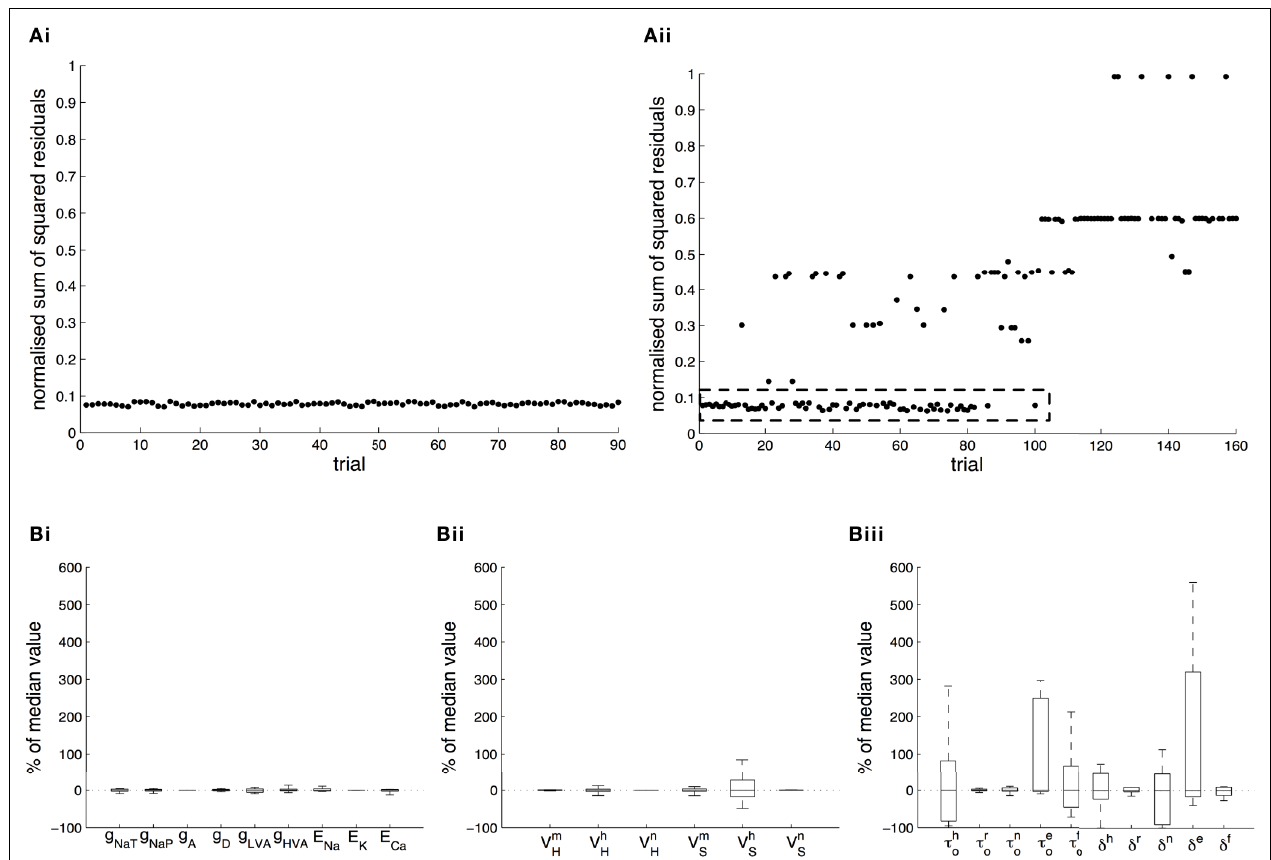
FIGURE 3 | Tolerance of optimal fi tting to variation in parameter values. simulations. (B) Examination of the estimated maximal conductance and (A) Optimization against current-clamp data was repeated from a large number reversal potential values corresponding to the optimal points illustrated in Ai of randomly selected initial values for the maximal conductances and reversal revealed that these values were tightly constrained around the median, not potentials in the model, while the rest of the parameters were kept fi xed to their exceeding 15% of this value (Bi) . Similarly, the optimal values for parameters V m previously estimated values. A total of 90 different initial values for each free parameter were tested, all of which converged to the same equally good fi t to the data at the end of the optimization (Ai) . Similarly, the optimization based on current-clamp data was repeated for parameters V x and V x ( x = m,h,n) and τ ox H S and δ x ( x = h,r,n,e,f), while the rest of the parameters in the model, including maximal conductances and reversal potentials, were kept fi xed to their value (Bii) . On the other hand, the optimal values for most of the examined x and δ x ( x = h,r,n,e,f) were rather broadly distributed around the previously estimated values. We tested 140 randomly distributed initial values parameters τ o x ( x = h,r,n,e,f), among which only for each of the parameters V x ( x = m,h,n) and τ median (Biii) . All parameters in Bi–iii were centered and normalized with o H 63 (45%) converged to a suffi ciently good fi t to the current-clamp data ( Aii , respect to the median. The lower and upper edges of each box in the same plots dashed rectangular region). All 230 points illustrated in Ai and Aii were correspond to the 25th and 75th percentiles, respectively, while the whiskers normalized by dividing with the largest sum of squared residuals found in these above and below each box indicate the most extreme parameter